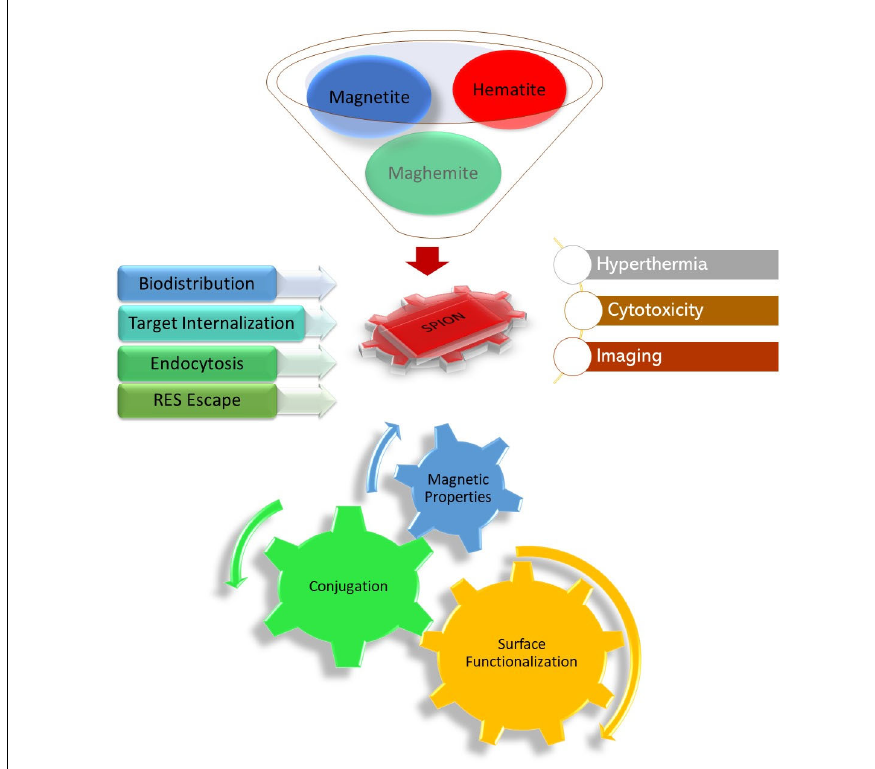
Figure 2. SPIONs’ core types, modification ‐ activation, bioresponses and biological activity.